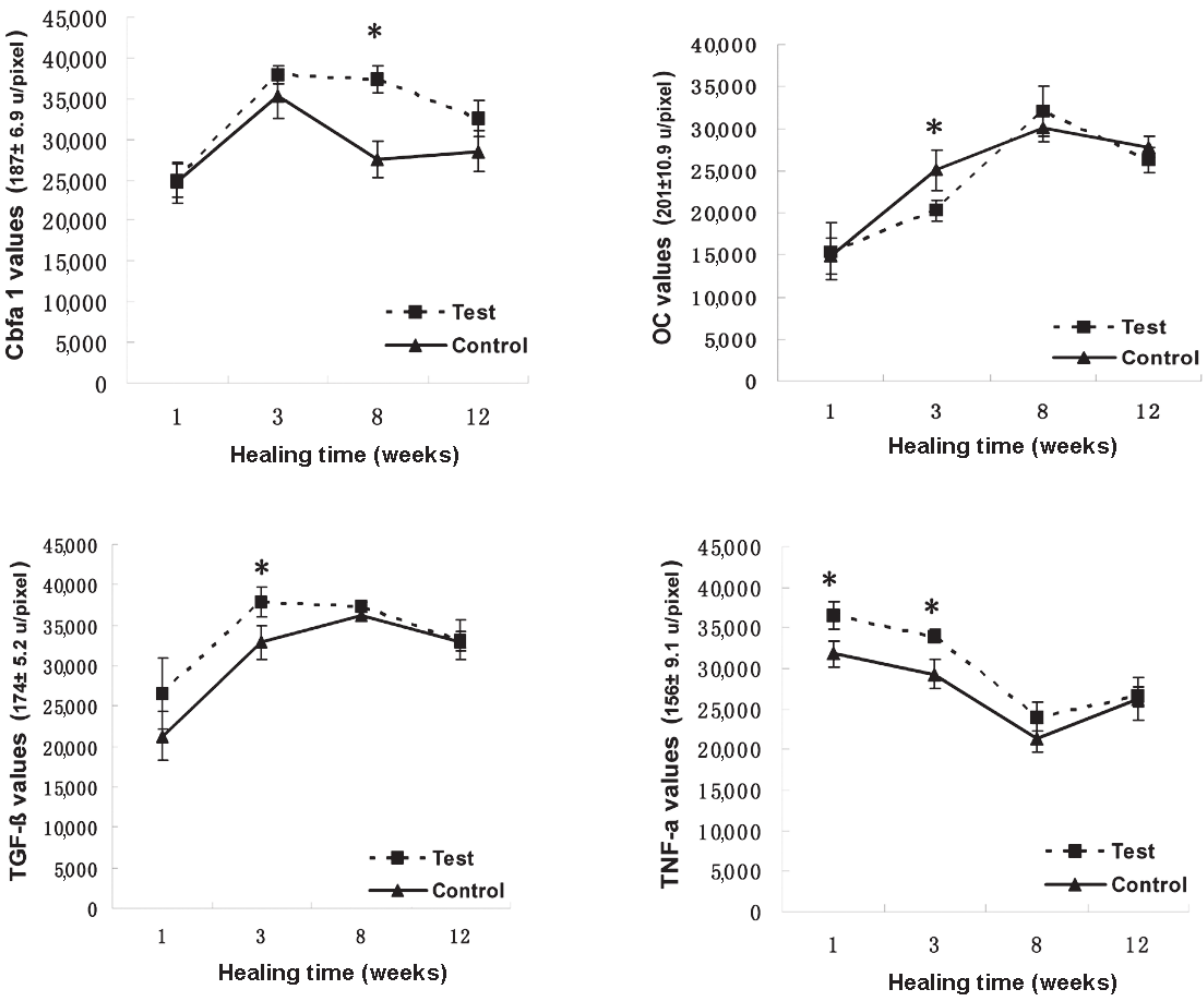
Figure 5- Graphs showing the changes in expression of Cbfa1, osteocalcin (OC), TGF-β and TNF-α, in both groups at 1, 3, 8 and 12-week healing time. * indicates statistically significant differences. (a) At week 8, the expression in the test group was significantly higher than in the control group (p<0.01). (b) The expression of OC reached peak values at week 8 and subsequently decreased. Significant differences were observed at week 3 and values of OC in the control group were significantly higher than in the test group (p<0.01). (c). The peak of TGF-β in the control group appeared at week 8, and subsequently went down to the level as in week 3. At week 3, significant differences were observed between both groups, but the expression of TGF-β in test groups was stronger than in control groups (p<0.01). (d) Significant differences in expression between two groups were observed at week 1 and week 3, and the values in the test group were higher than those in the control group (p<